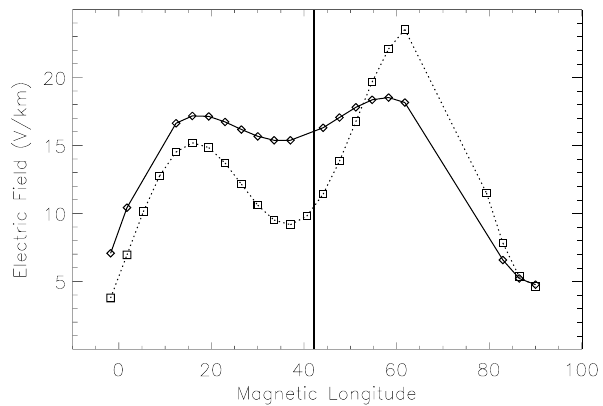
Fig. 10. Longitudinal (MLT) variation of the zonal component of the convection electric field at 73.5 ◦ geomagnetic latitude deter- mined from the global convection mapping technique for the in- terval 14:00–14:02 UT on 11 February 1998. The dotted line repre- sents the variation obtained from using the default processing (as in Figure 9a), whereas the solid line represents the variation obtained from using velocity-range gate filtering (as in Fig.